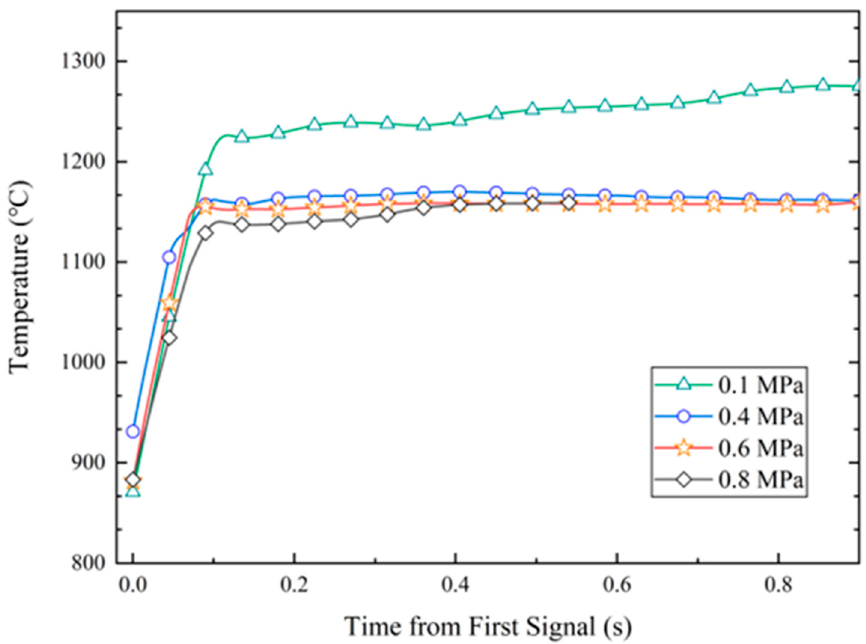
Figure 13. Representative temperature of single Al-Li alloy at different ambient pressures (signal has been smoothed).